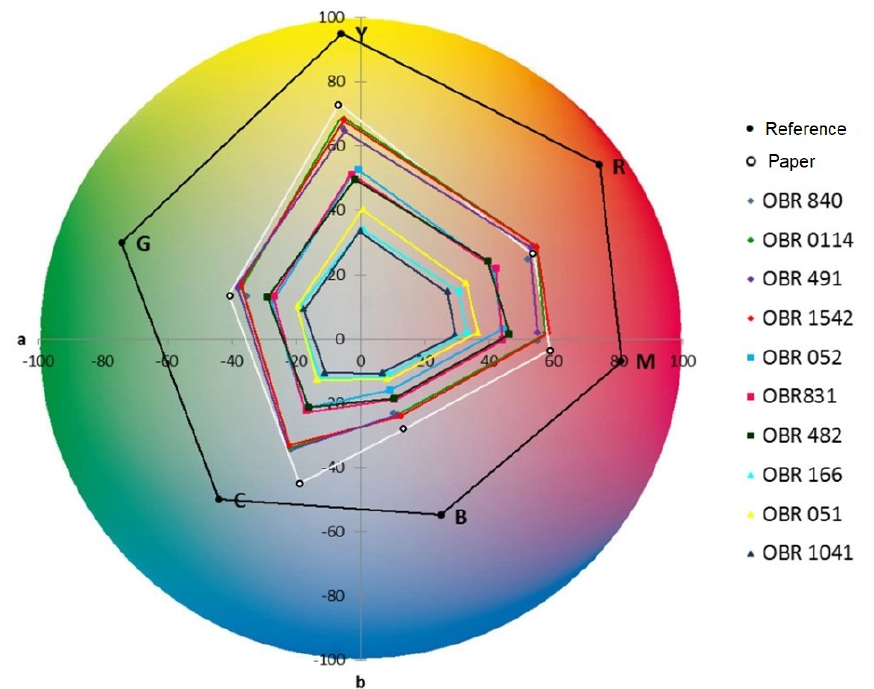
Figure 14. Color reproduction on different linen fabric in a * b * when printing in 4 passes with 2 ink layers. The range of digital reference colors (black line) show that it is possible to reach the limits of maximum rich colors and the range of colors is reproduced in the print on paper (white line). Limited color saturation reproduction on all types of linen fabrics is clearly visible. The most affected are cyan and blue (B) color saturation. Color reproduction in prints on bleached linen fabrics is closest to color reproduction on paper. There is a